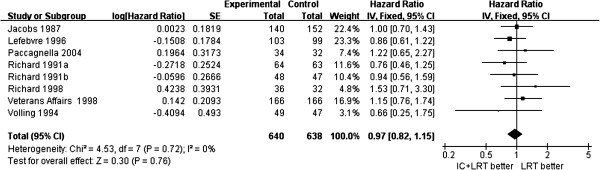
Forest plot of hazard ratios for disease-free survival and 95% CI in patients with resectable head and neck squamous cell carcinoma treated with induction chemotherapy followed by locoregional treatment, or locoregional treatment alone. Richard 1991a23 is for cancer of the floor of the mouth, Richard 1991b23 is for cancer of the posterior oral cavity and oropharynx. Jacobs 198717, Lefebvre 199624, Paccagnella 200411, Richard 199825, Veterans Affairs 199827, Volling 199413.